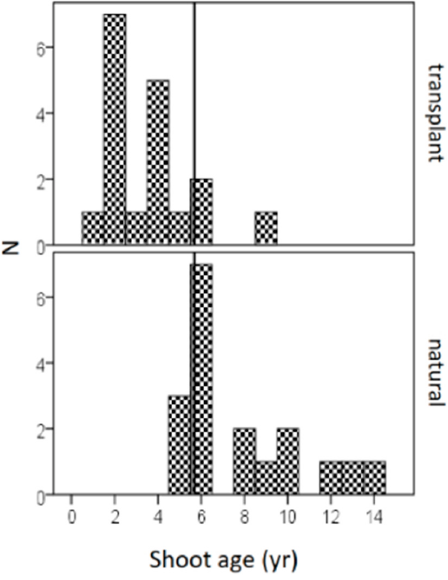
Figure 8. Frequency of shoot age histograms for both beds. The vertical line represents the general mean shoot age.